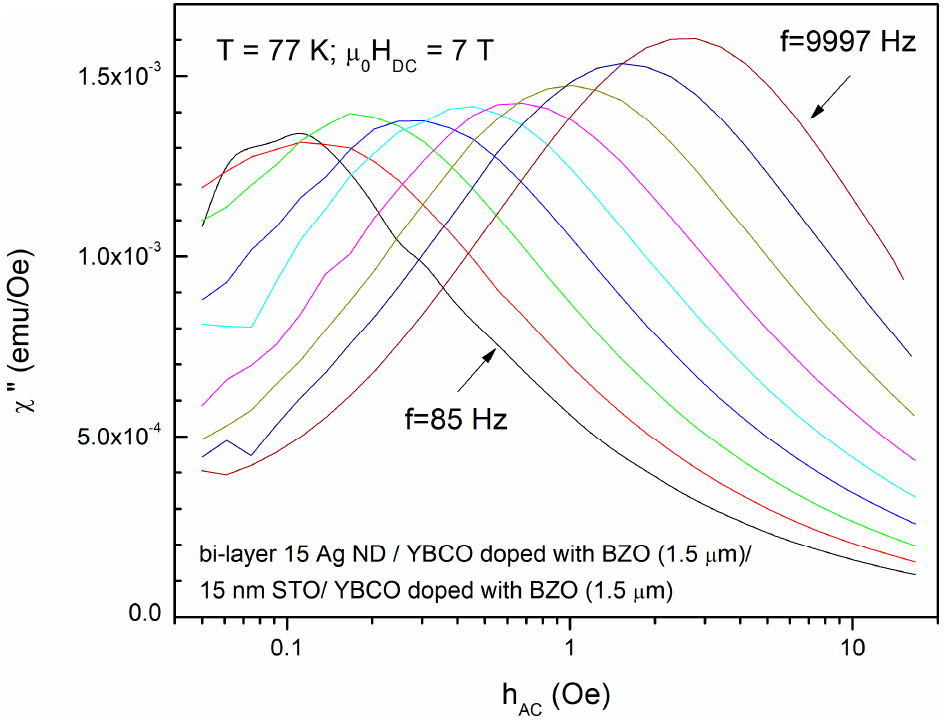
Figure 1. AC field amplitude h ac dependence of the out-of-phase susceptibility χ″ of the bi-layer film composed of two BZO-doped YBCO films of 1.5 µm thickness, grown on substrates decorated with Ag nano-islands, separated by a nanolayer (15 nm) of insulating STO, at 77 K, in a DC field of 7 T, and at various frequencies (different colors) between 85 and 9997 Hz.